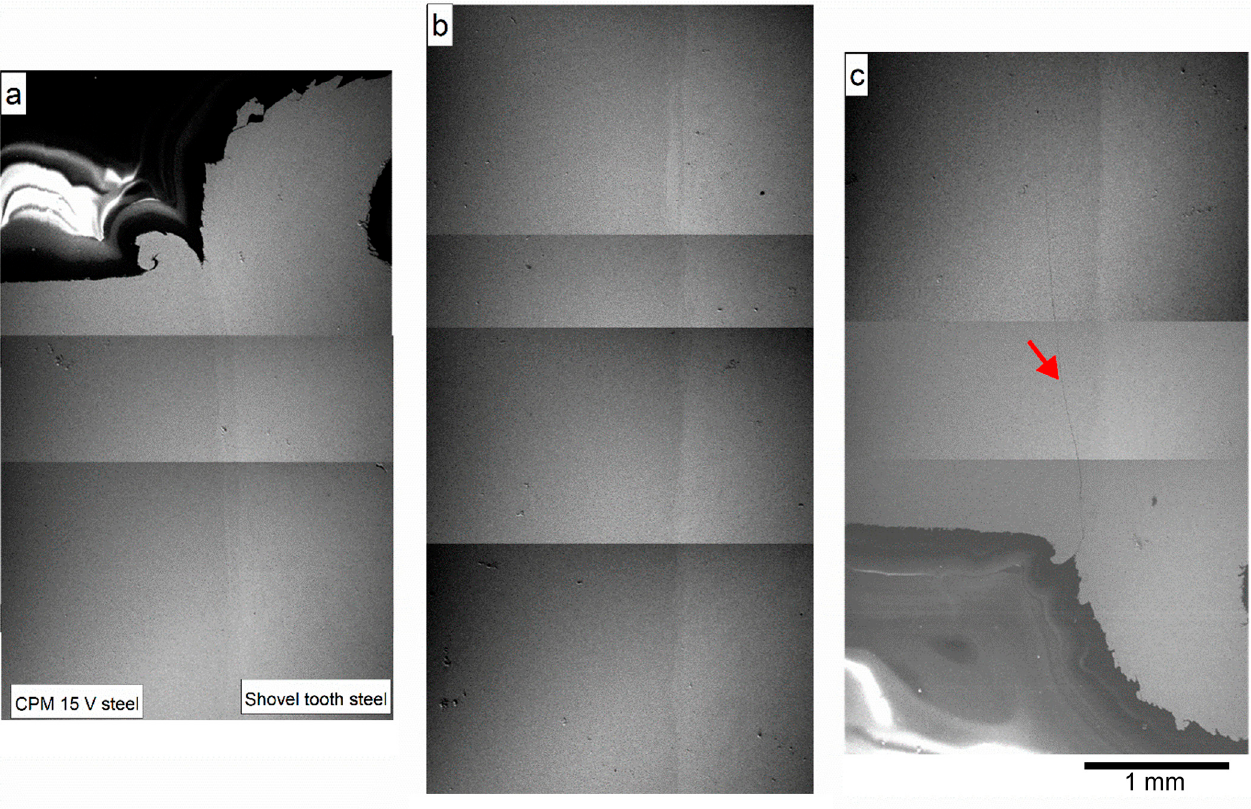
Figure 8. SEM micrographs taken at the interface (along Plane A in Figure 2) from ( a ) left, passing through ( b ) the middle, to ( c ) the right of the LF weld, where the arrow demarcated in ( c ) highlights the crack that originated at the flash surface and extended into the CPM 15V tool steel .